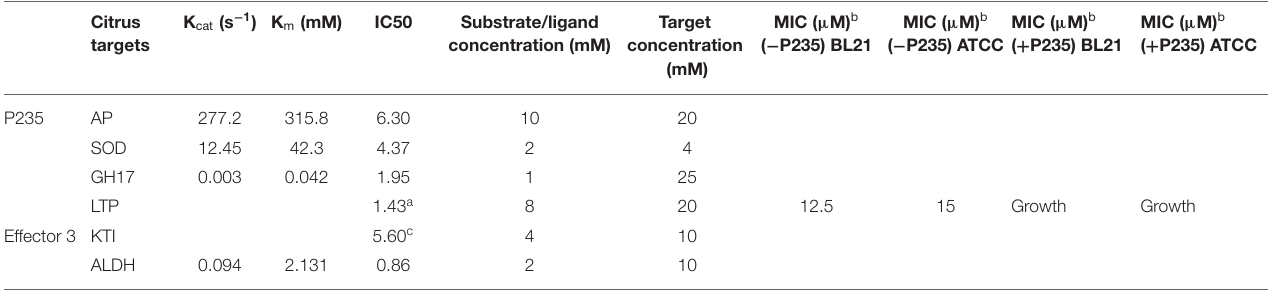
TABLE 1 | The citrus AP, SOD, GH17, and ALDH were overexpressed in and purified from E. coli and enzymatic assays were performed on them following the protocols described in Experimental Procedures section. Citrus